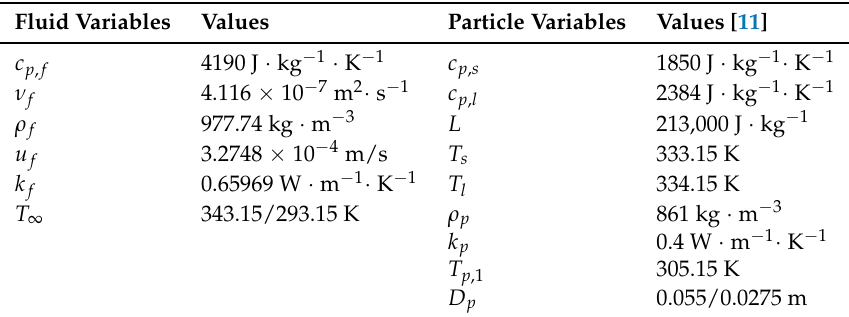
Table 1. Model parameter cases.